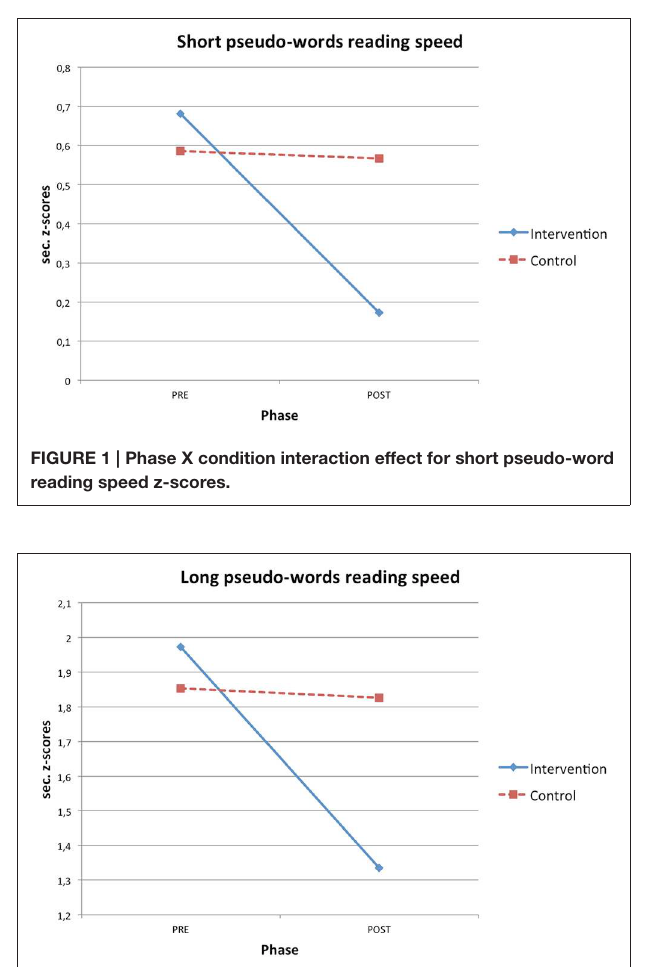
FIGURE 4 | Phase X condition interaction effect for text reading accuracy